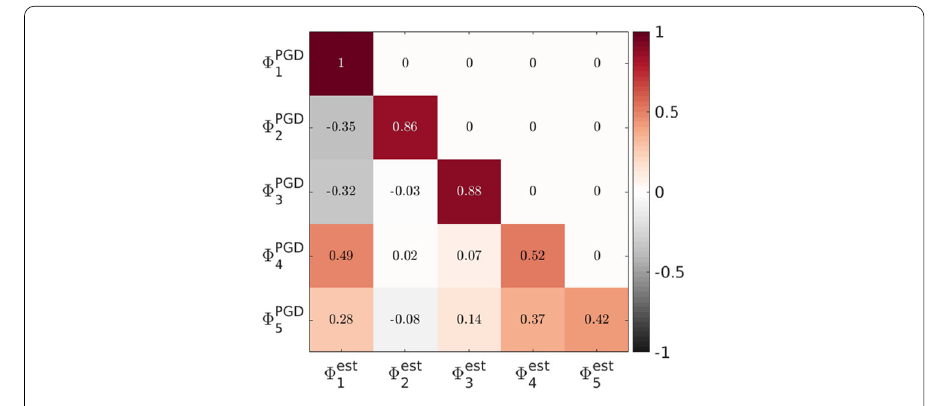
Fig. 8 The estimated vibration modes (cid:2) est i are computed with a Gram-Schmidt orthonormalization procedure from (cid:2) PGD